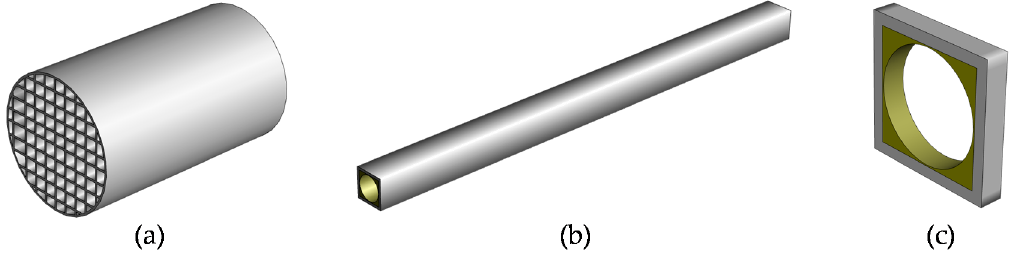
Figure 1. Schematic of ( a ) a honeycomb type substrate, ( b ) a single channel and ( c ) a cross-section of a coated channel.